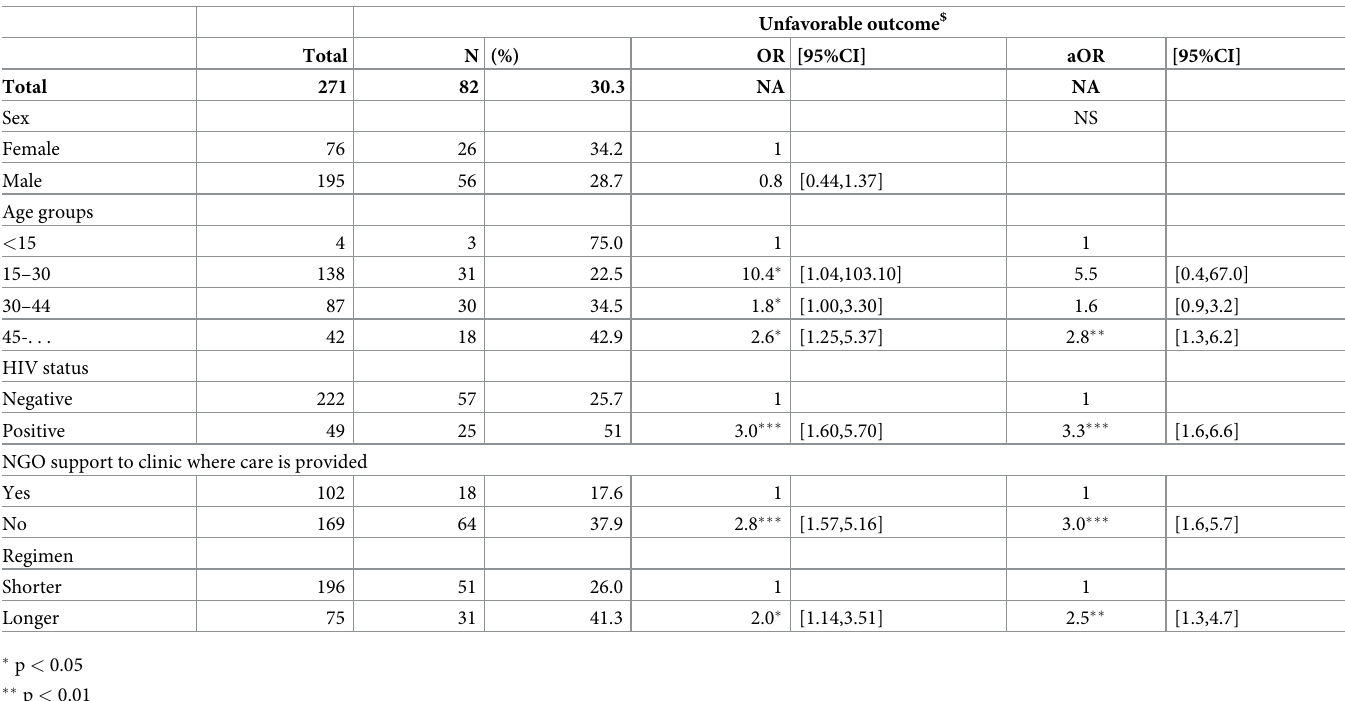
Table 3. Predictors of an programmatically adverse treatment outcome, among 271 patients started on MDR-TB treatment in Guinea, between 2016 and